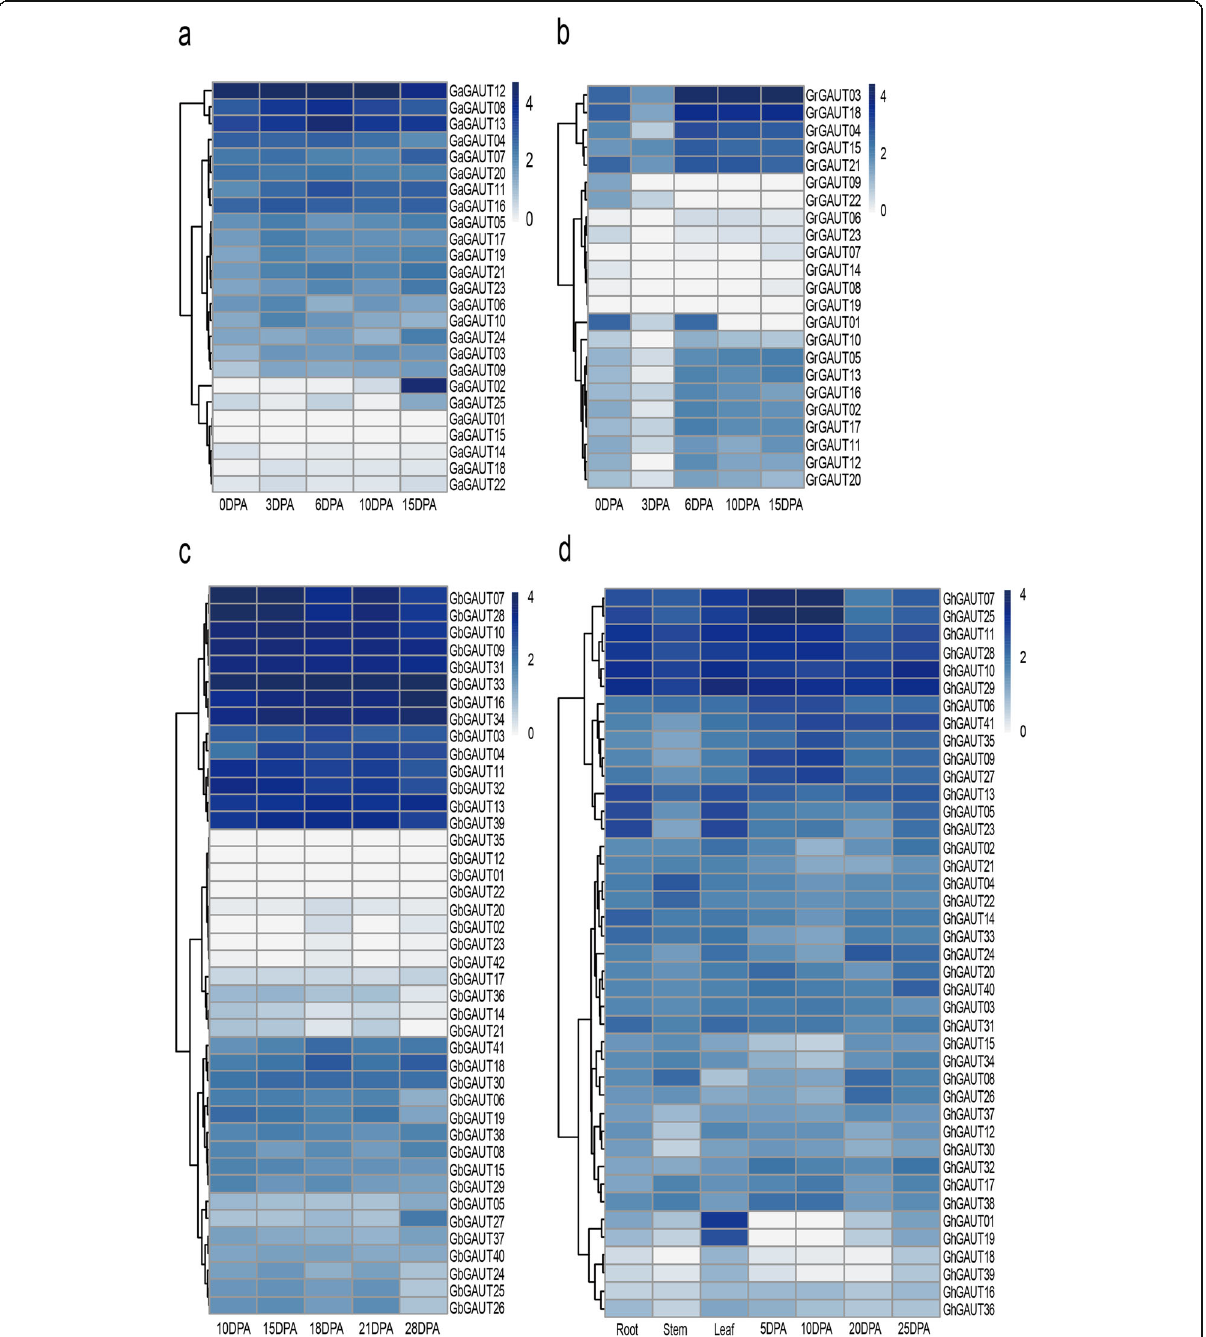
Fig. 4 Heatmap of the galacturonosyltransferase gene transcript levels based on transcriptome analysis. a : galacturonosyltransferase gene transcript levels during fiber development in G. arboreum (0 to 15 DPA). b : Galacturonosyltransferase gene transcript levels during fiber development in G. raimondii (0 to 15 DPA). c : Galacturonosyltransferase gene transcript levels during fiber development in G. arboreum (10 to 28 DPA). d : Galacturonosyltransferase gene transcript levels in the root, stem, leaf, and fiber tissues (5 to 30 DPA) from G.